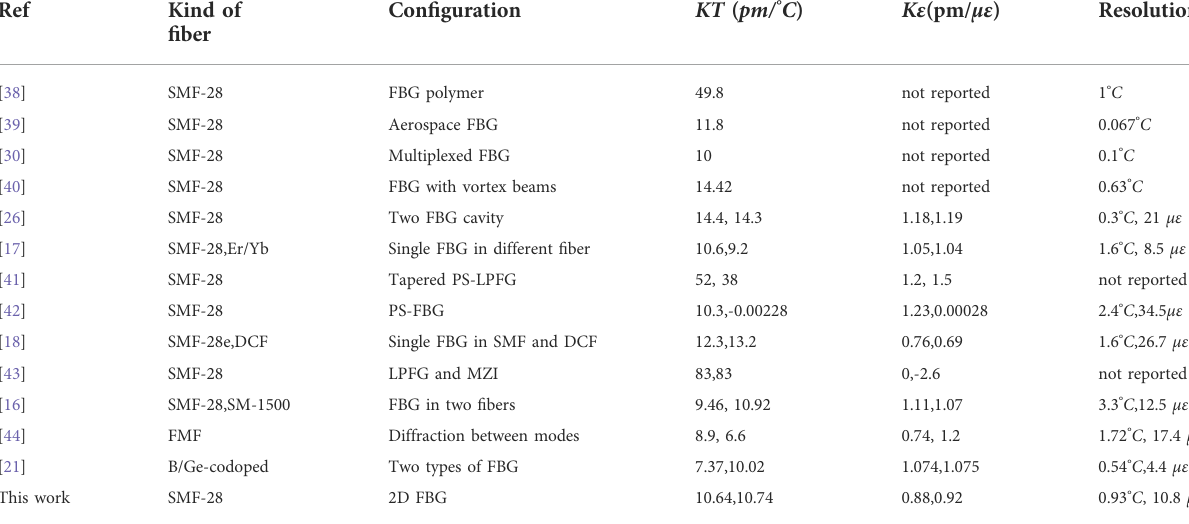
TABLE 1 Comparison between several methods for measurement of temperature and